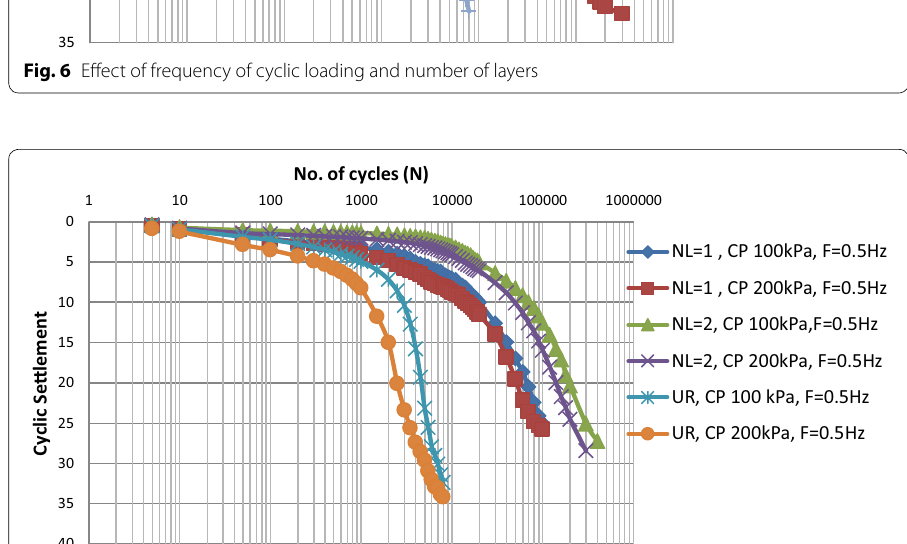
Fig. 7 Effect of cyclic pressure (amplitude) of cyclic loading and number of